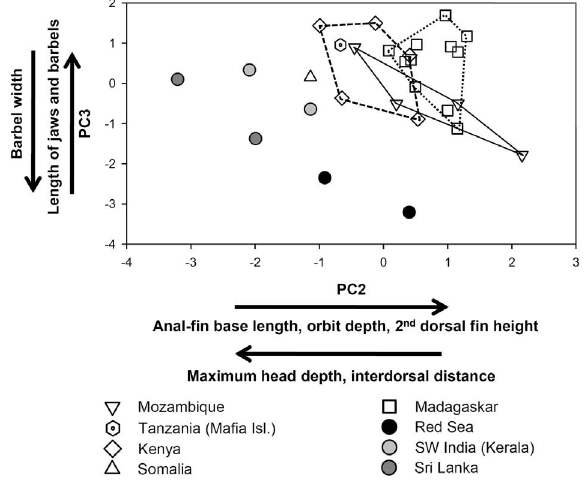
Fig . 3. – Scores of the second and third axis of Principal Compo- nent Analysis based on 40 morphometric characters in 28 Upeneus margarethae from different areas in the western Indian Ocean, with trends for the highest contributing characters indicated by